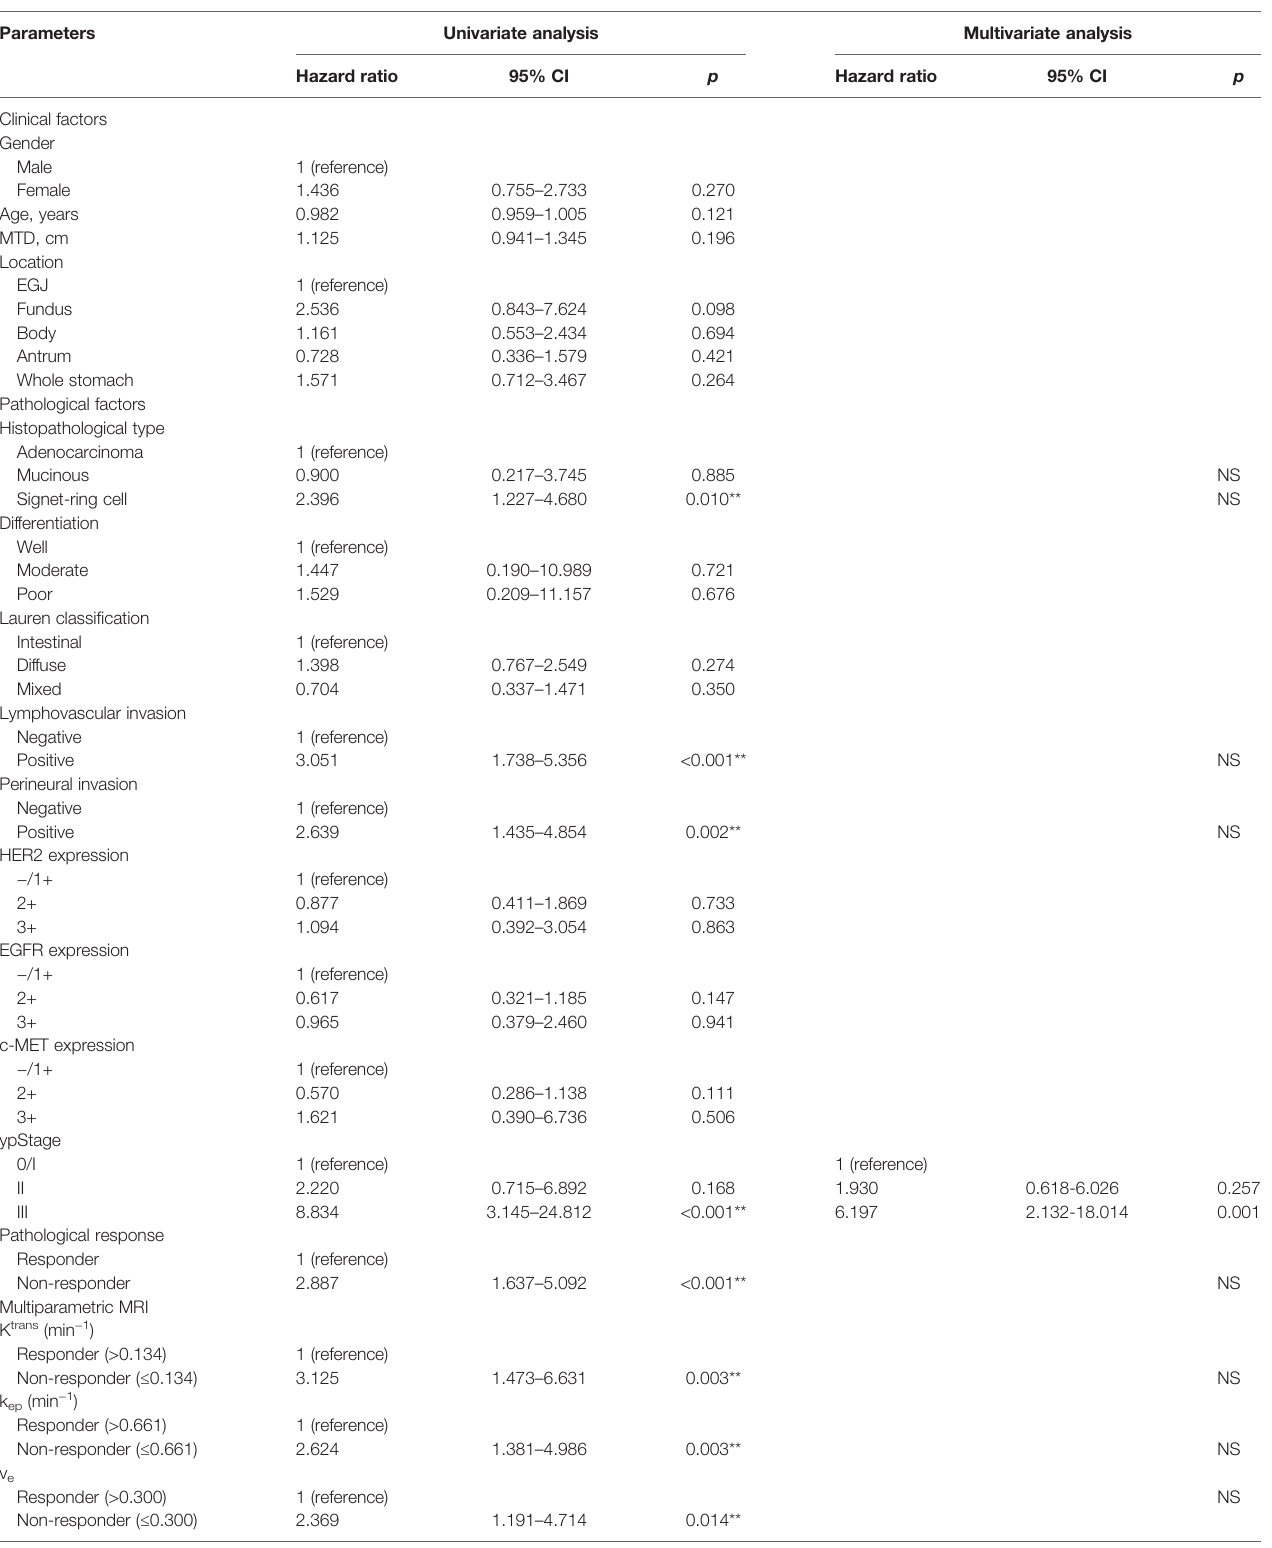
TABLE 5 | Univariate and multivariate Cox proportional hazards prediction analyses of recurrence-free survival according to responder and non-responder groups determined by baseline DCE-MRI and IVIM-DWI quantitative parameters and their combination